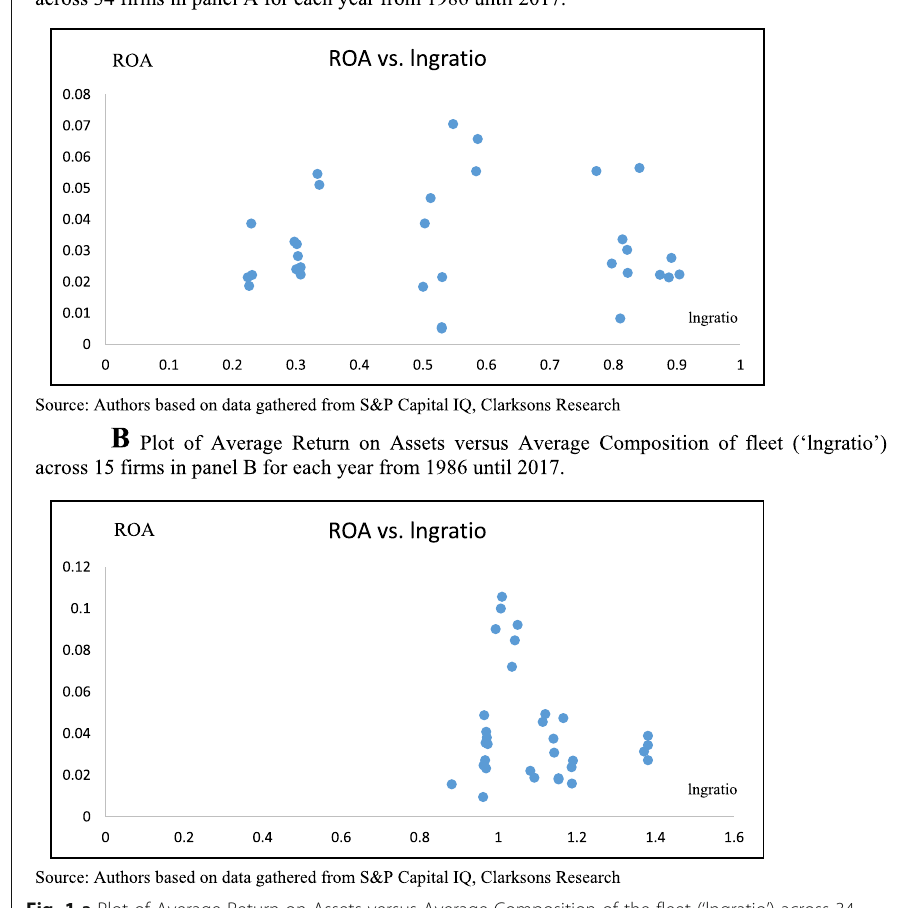
Fig. 1 a Plot of Average Return on Assets versus Average Composition of the fleet ( ‘ lngratio ’ ) across 34 firms in panel A for each year from 1986 until 2017. Source: Authors based on data gathered from S&P Capital IQ, Clarksons Research. b Plot of Average Return on Assets versus Average Composition of fleet ( ‘ lngratio ’ ) across 15 firms in panel B for each year from 1986 until 2017. Source: Authors based on data gathered from S&P Capital IQ, Clarksons